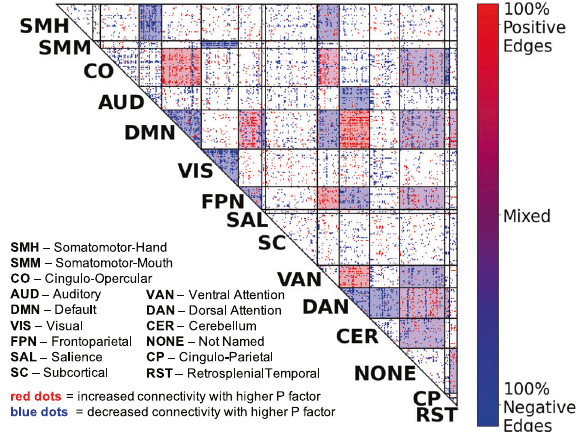
which identi fi es cells (i.e., sets of connections linking pairs of large- scale networks) where the number of P-factor-related edges exceeds